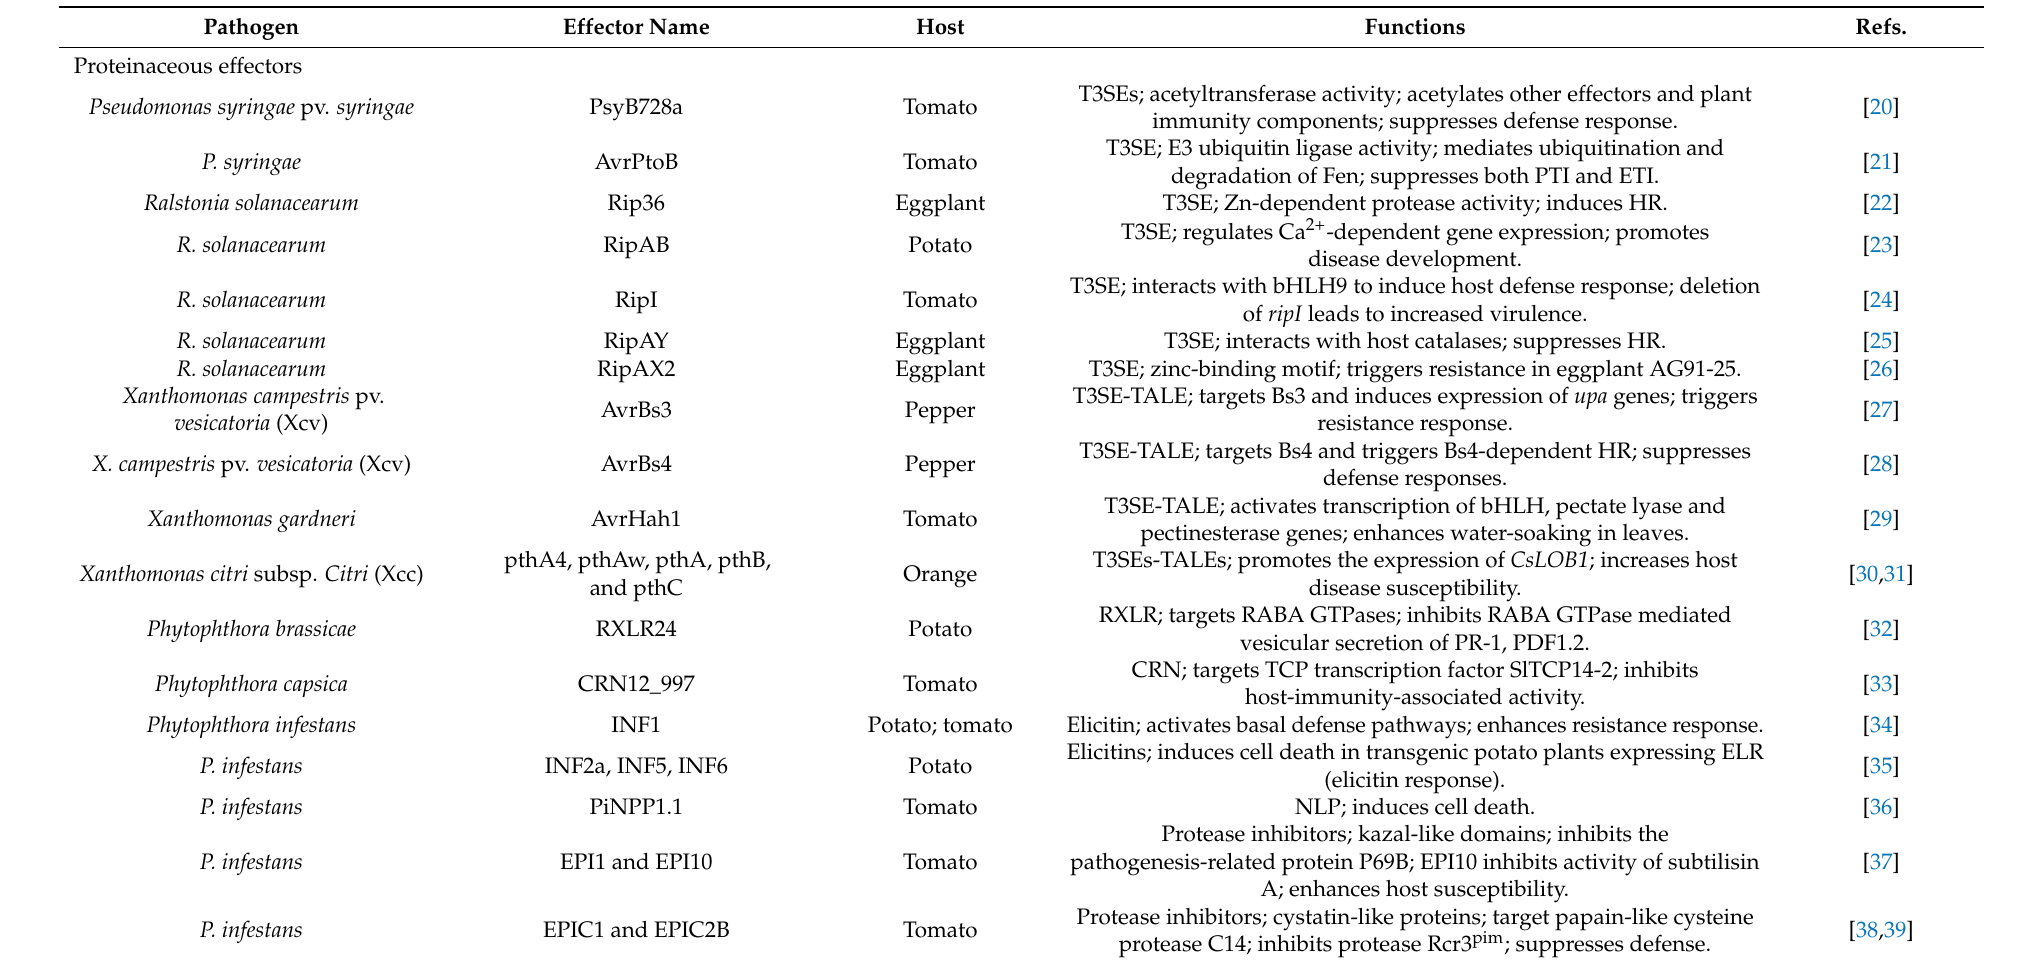
Table 1. Examples of identified and characterized effectors in horticultural crop